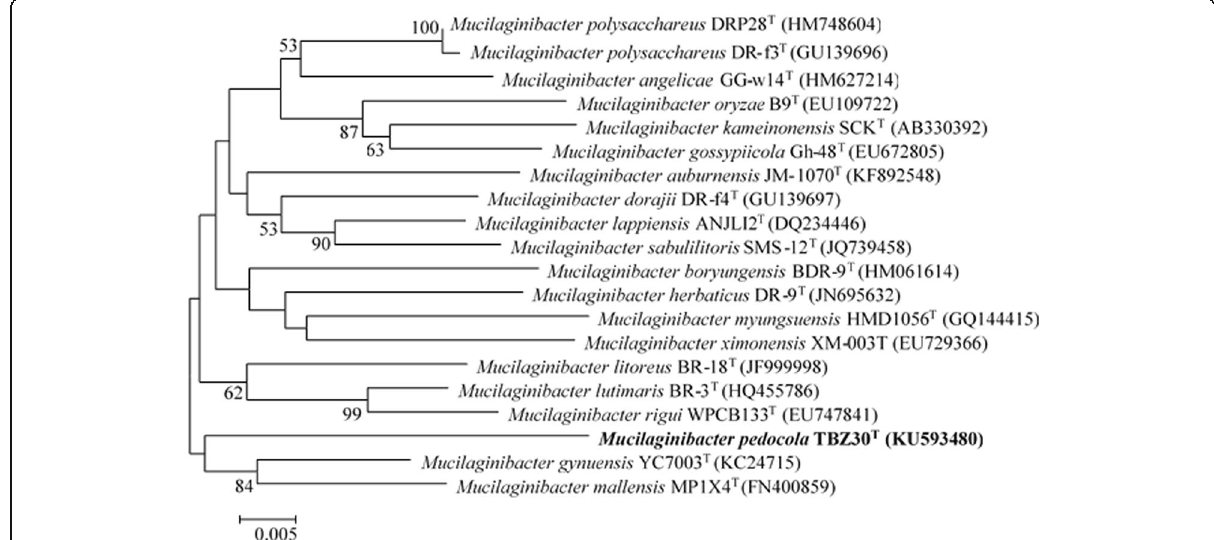
Fig. 1 A neighbor-joining phylogenetic tree based on 16S rRNA gene sequences showing the phylogenetic relationships of strain TBZ30 T and the related species. The bootstrap value less than 50% are not shown. Bar, 0.005 substitutions per nucleotide position